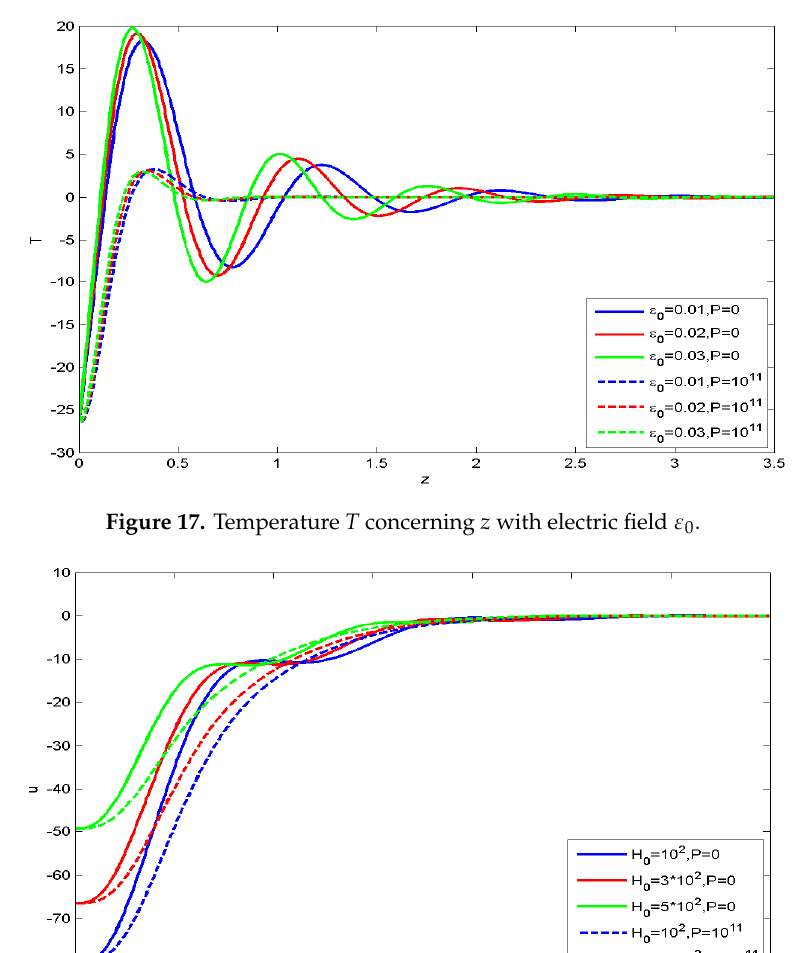
Figure 18. Horizontal displacement u concerning z with magnetic field H 0 .